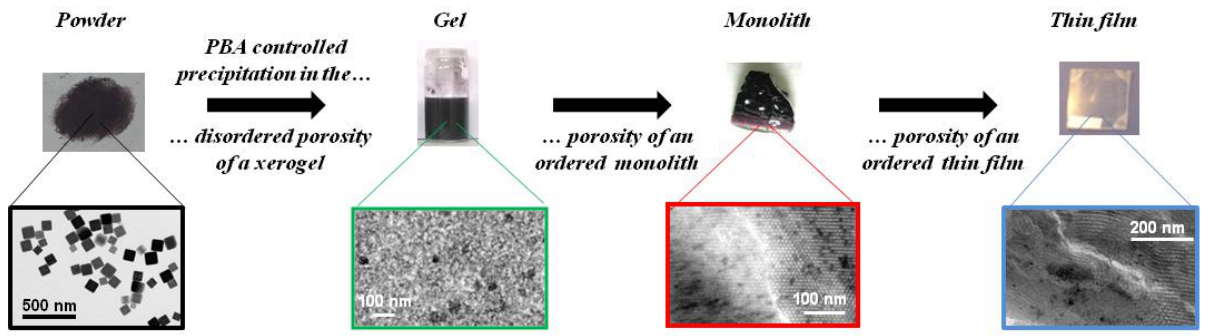
Figure 1. Illustration of the step-by-step approach for Prussian blue analogues (PBAs)